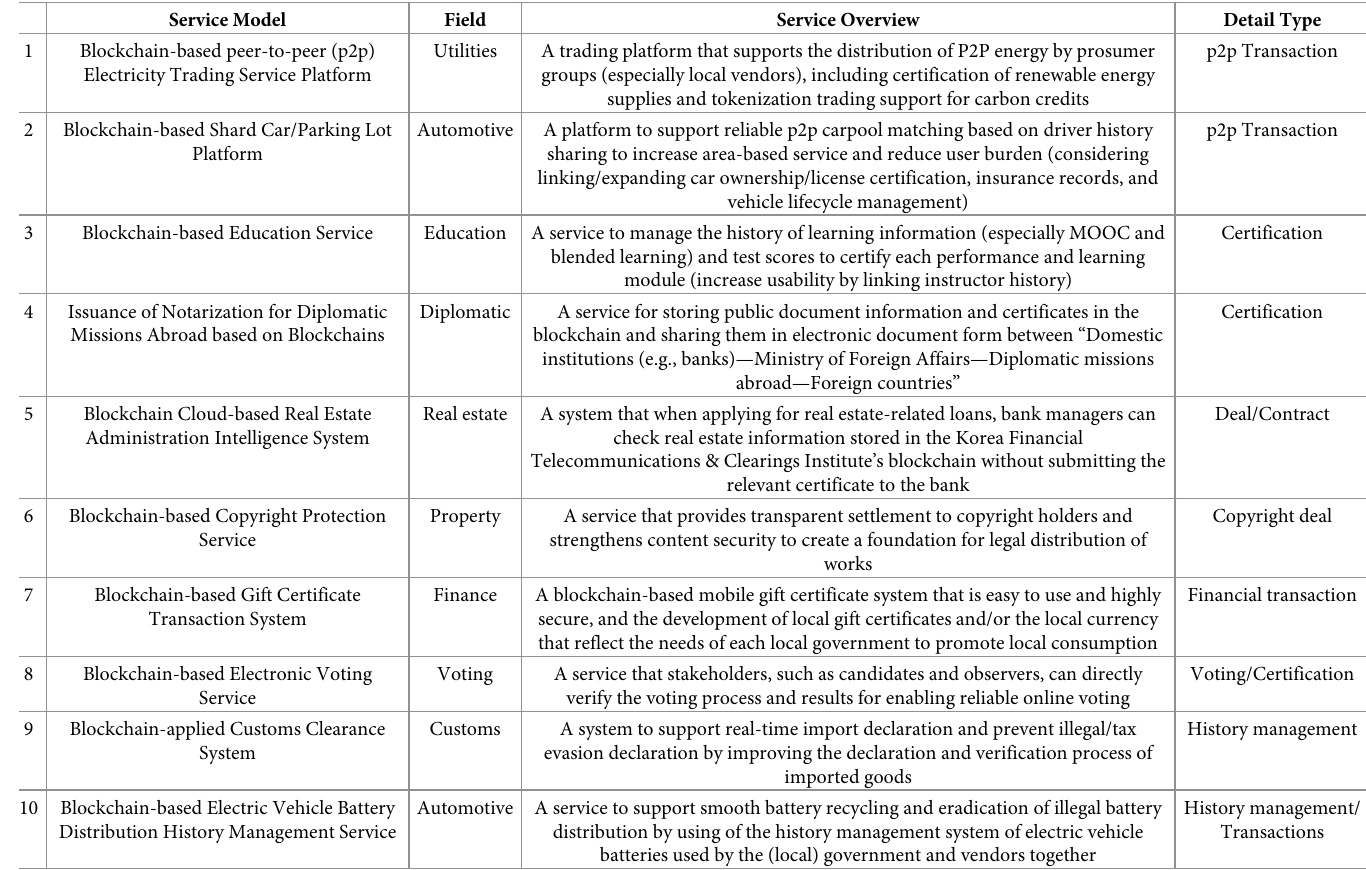
Table 5. The 10 final selected use